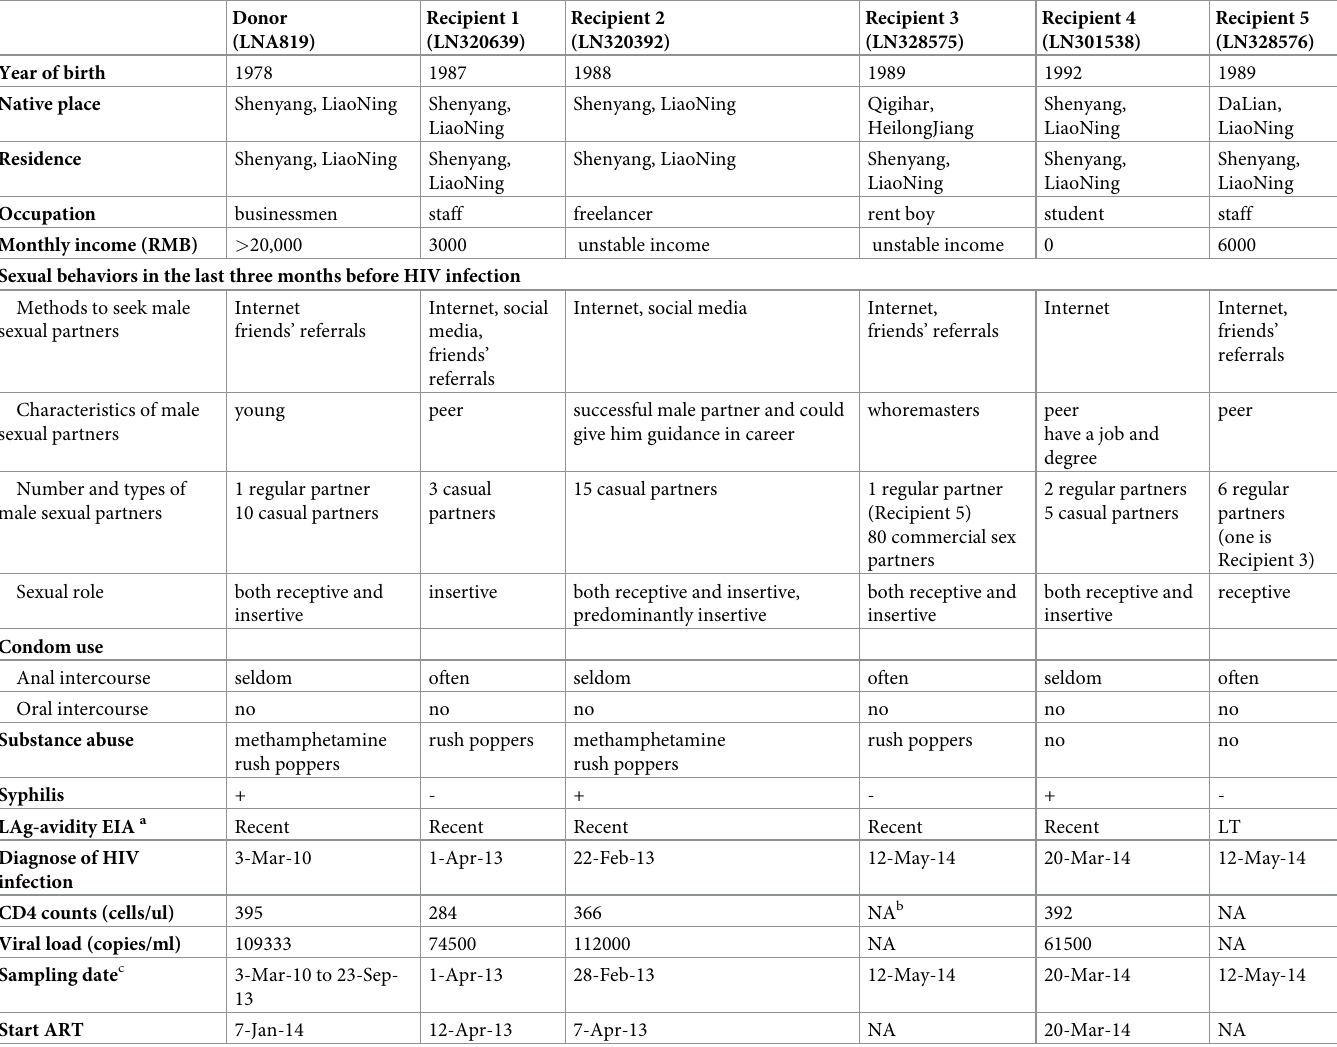
Table 1. Sociodemographic characteristics, sexual behaviors, and clinical records of six patients diagnosed with HIV